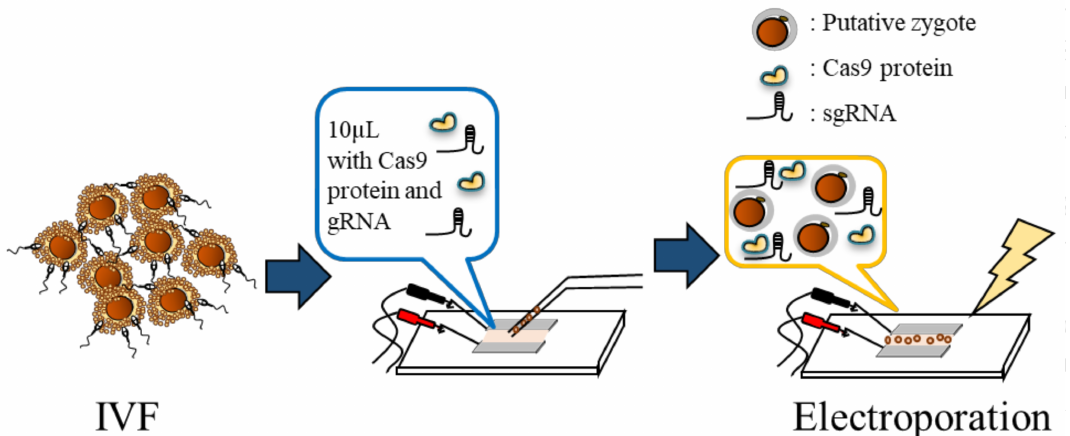
Figure 2. Schemes of genome editing using the electroporation method. Approximately 30–40 putative zygotes were placed in a line in the electrode gap, in a chamber slide filled with 10 µ L of Opti-MEM I solution with Cas9 protein and gRNA, and were then electroporated by 25 V / mm, 1 ms, and five repeats. IVF: in vitro